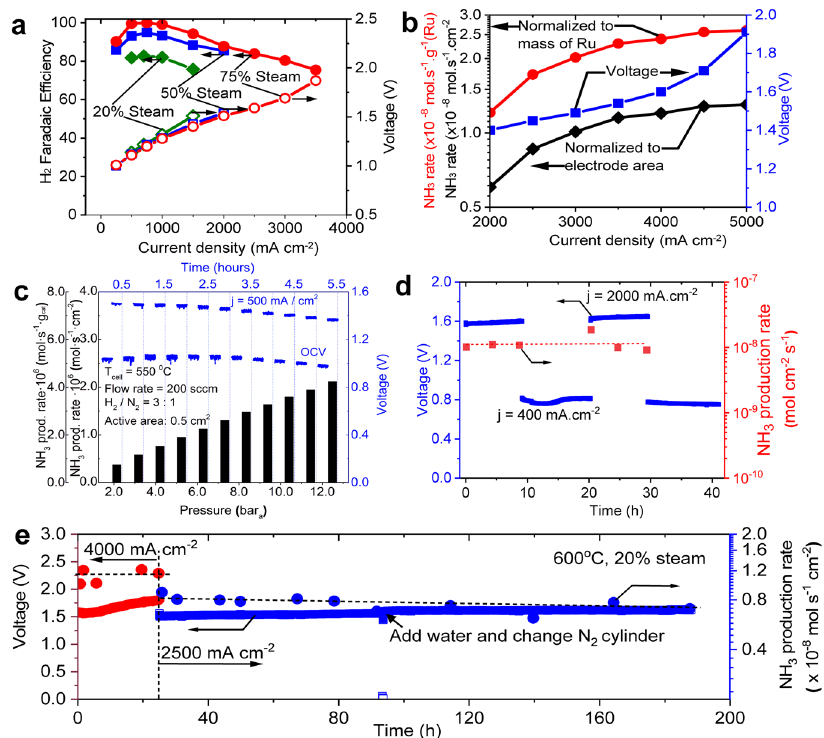
Fig. 6 Ammonia production and reversible operation. a Measured FE and voltage as a function of applied current density at 600 °C. For FE measurement, ultra-high purity N 2 was used as carrier gas. b Cell potential and NH 3 -synthesis rate as a function of current density at ambient pressure (NH 3 synthesis rate is shown normalized to both cell active area and catalyst mass). PCFC at 600 °C and ammonia synthesis at 400 °C. c NH 3 -synthesis rate as a function of operating pressure from 2 to 12.5 bar a . NH 3 -synthesis rate (on the primary y-axis) is normalized both by catalyst loading (g cat ) and electrochemically active area (0.5 cm 2 ). During the nearly 6 h of NH 3 synthesis, the electrochemical cell was driven at a current density of 0.5 A cm − 2 , while additional H 2 was supplied to the reactor to maintain 3:1 H 2 :N 2 stoichiometry. Open-circuit voltage and cell potential during discharge are shown on the secondary y-axis. Driving voltage is found to decrease with increasing operating pressure. d Reversible NH 3 -synthesis/NH 3 fuel-cell operation with two 20-hour cycles. PCFC cell at 600 °C, ammonia synthesis at 400 °C and ammonia cracking at 600 °C. e Stability under ammonia production modes for over 160 h of continuous operation. PCFC at 600 °C, ammonia synthesis at 400